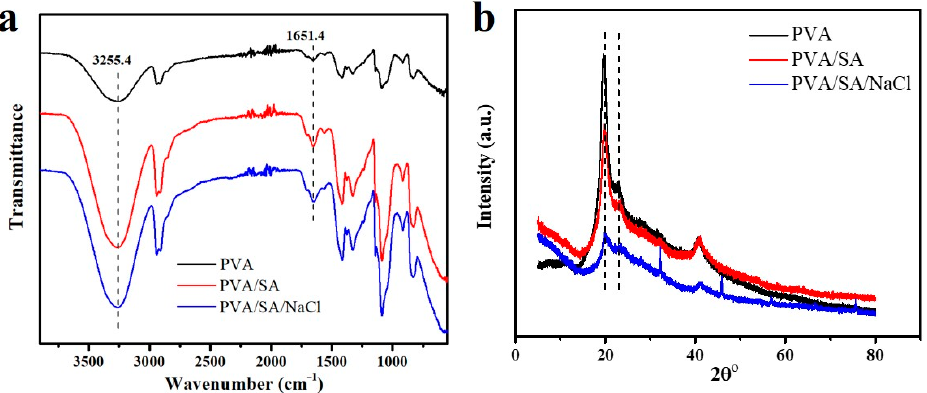
Figure 2. ( a ) ATR-FTIR spectra of the three types of hydrogels; ( b ) X-ray diffraction (XRD) patterns of the three types of hydrogels. The hydrogels were dehydrated by freeze-drying, before character- ization.